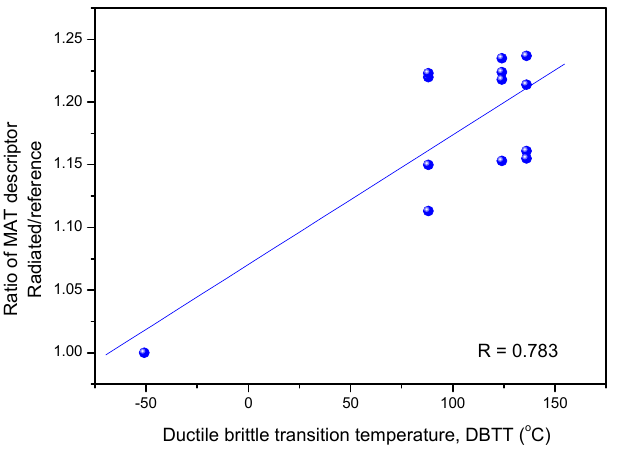
Figure 5. Ratio (normalized to the reference condition) of the optimally chosen MAT descriptor of all irradiated and not-irradiated samples as a function of the transition temperature.